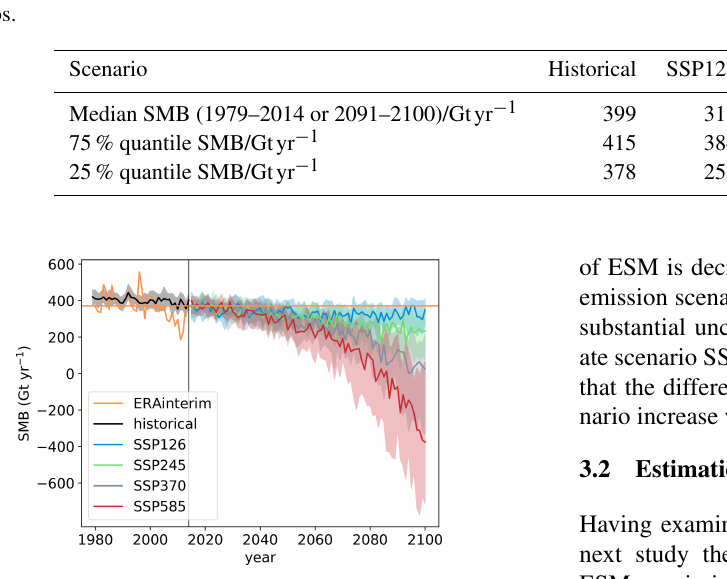
Figure 2. Surface mass balance simulations forced with ERA- Interim reanalysis data, historical ESM simulations, and scenario climate simulations, given as the median over the SMB for all snow model parameter combinations. The solid line is the median of all ESMs, and the shading shows the 25% and 75% percentiles. Or- ange represents SMB forced with ERA-Interim, and the horizontal line is its mean value.